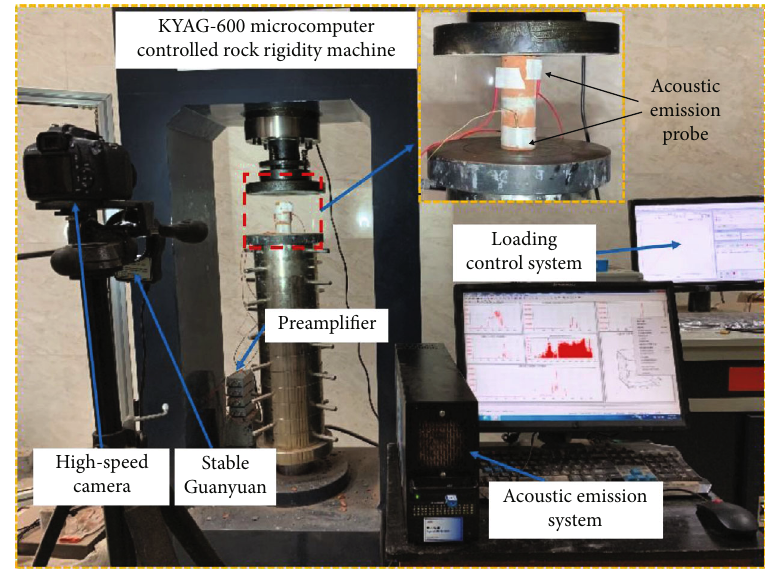
Figure 5: Sandstone test data acquisition system